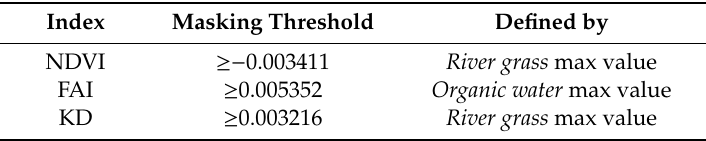
Table 2. Masking out threshold by index. Index